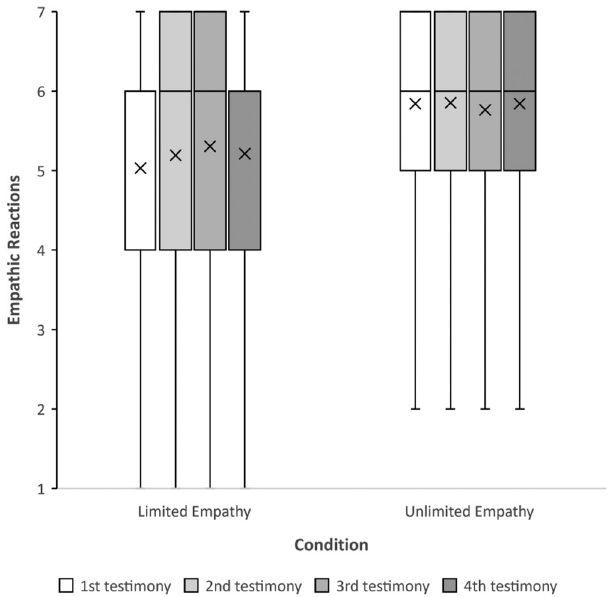
Fig.2|Empathicreactionstowardoutgrouptargets,asafunctionofCondition (i.e., limited empathy, n =99; and unlimited empathy, n =101) and order of empathy-inducing testimonies (i.e., 1 – 4). A signi fi cant main effect of condition on empathic reactions, F (1, 198)=8.93, p =0.003, d =0.423 (a repeated-measures ANOVA). The plot presents the maximum and minimum values as whiskers, the interquartilerangeastheverticallengthofeachbox,themeanasthexmarker,and the median as the horizontal line within each box. All tests are two-tailed. Source data are provided as a Source Data fi